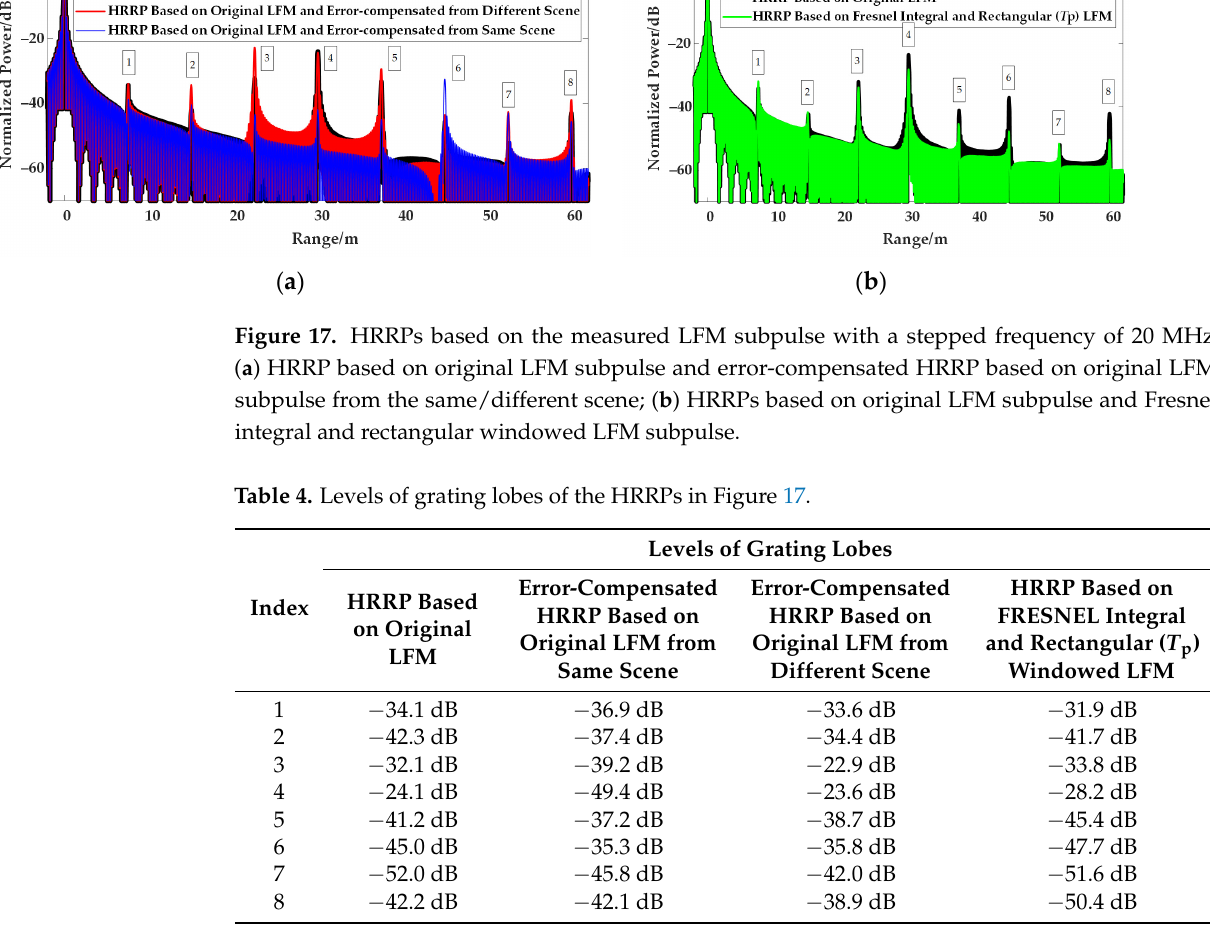
( b ) Figure 16. Experimental result of the effect of step frequency on visible grating lobes: ( a ) relation- ship between the number of the visible grating lobes and step frequency; ( b ) relationship between the levels of the visible grating lobes and step frequency. Next, the grating lobe level reduction based on Fresnel integral windowing is veri-